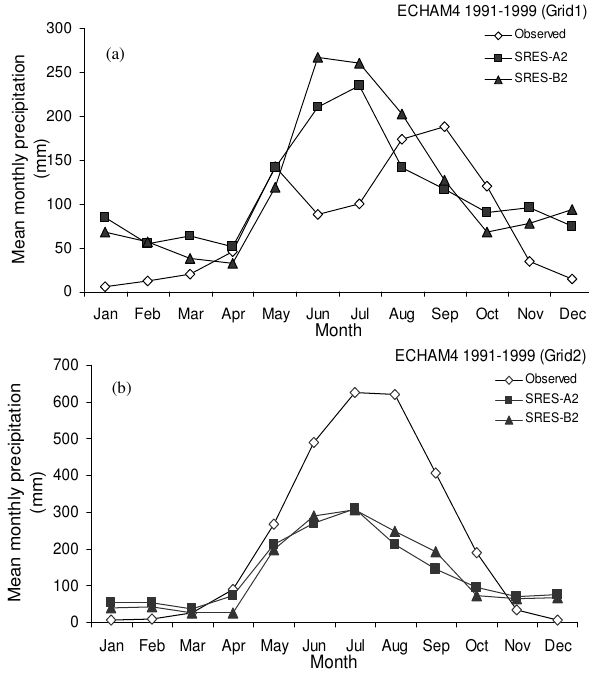
Fig. 4. Mean monthly rainfall trend of ECHAM4 SRES A2 and B2 scenarios compared with observed rainfall data (1990–1999) for (a) grid 1, and (b) grid